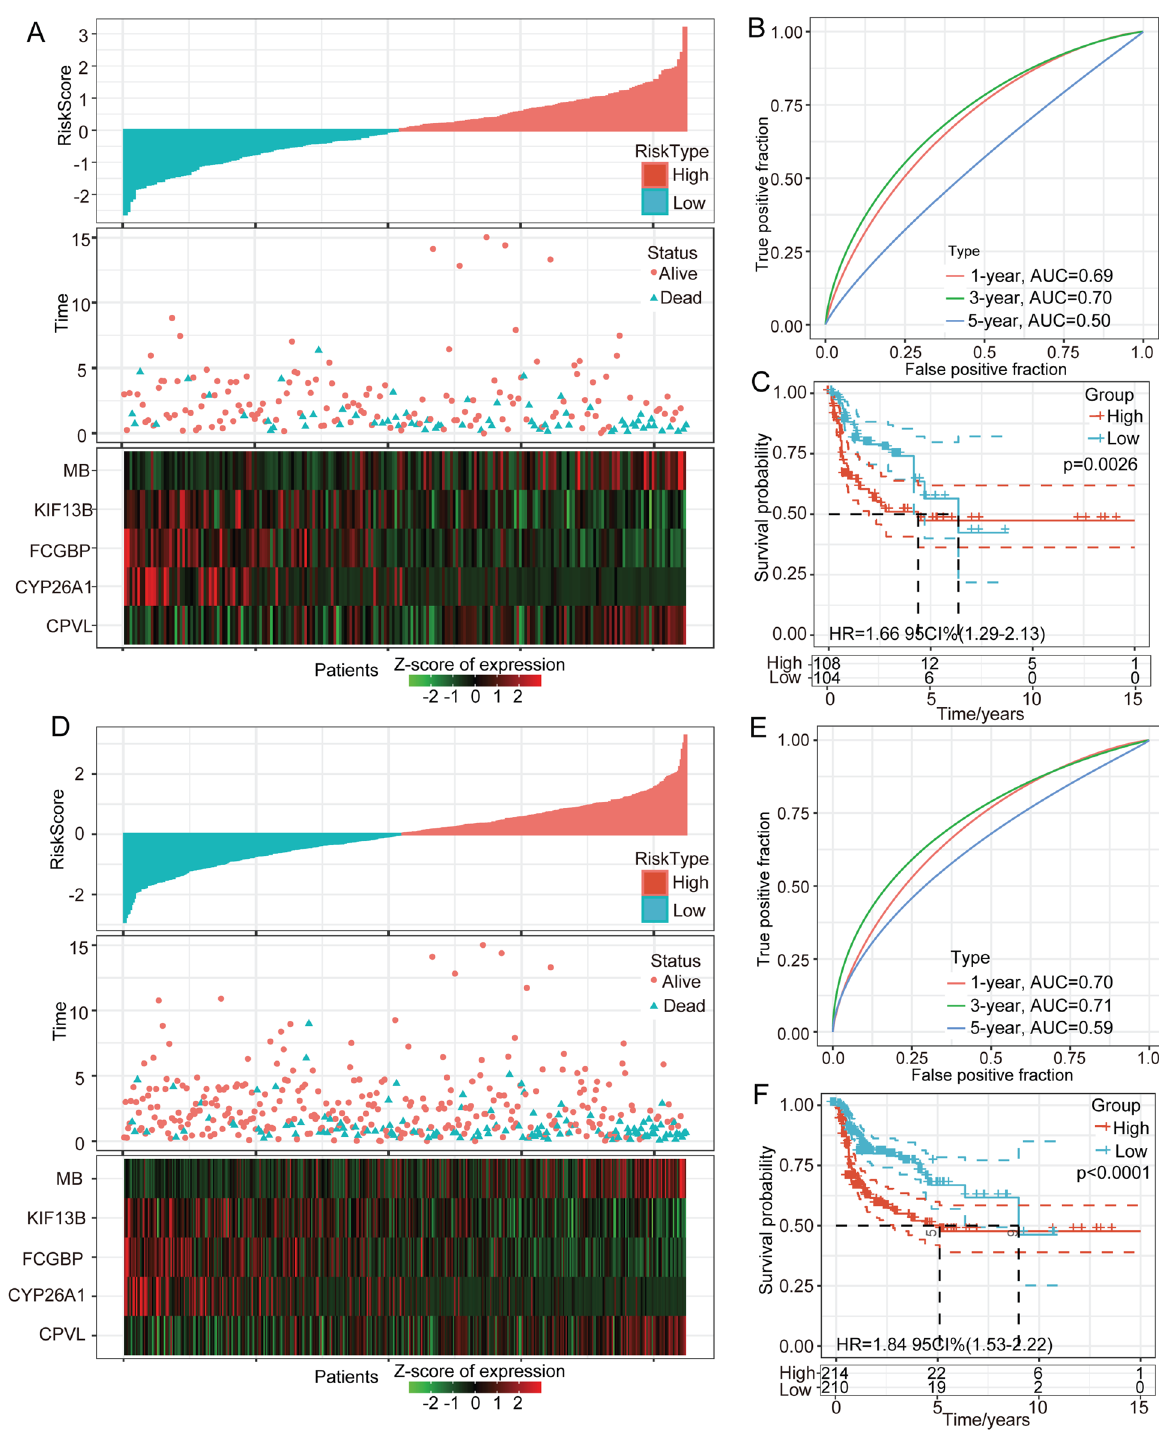
Figure 6. Validation of the m6A phenotype-associated prognostic model. ( A ) Risk score, survival time, survival status, five-gene expression, ACU curve, and KM curve of the TCGA validation dataset. ( B ) Risk score, survival time, survival status, five-gene expression, ACU curve, and KM curve of the TCGA all-sample validation